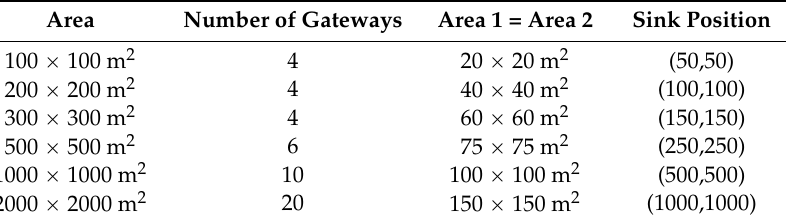
Table 3. Appropriate domain solution